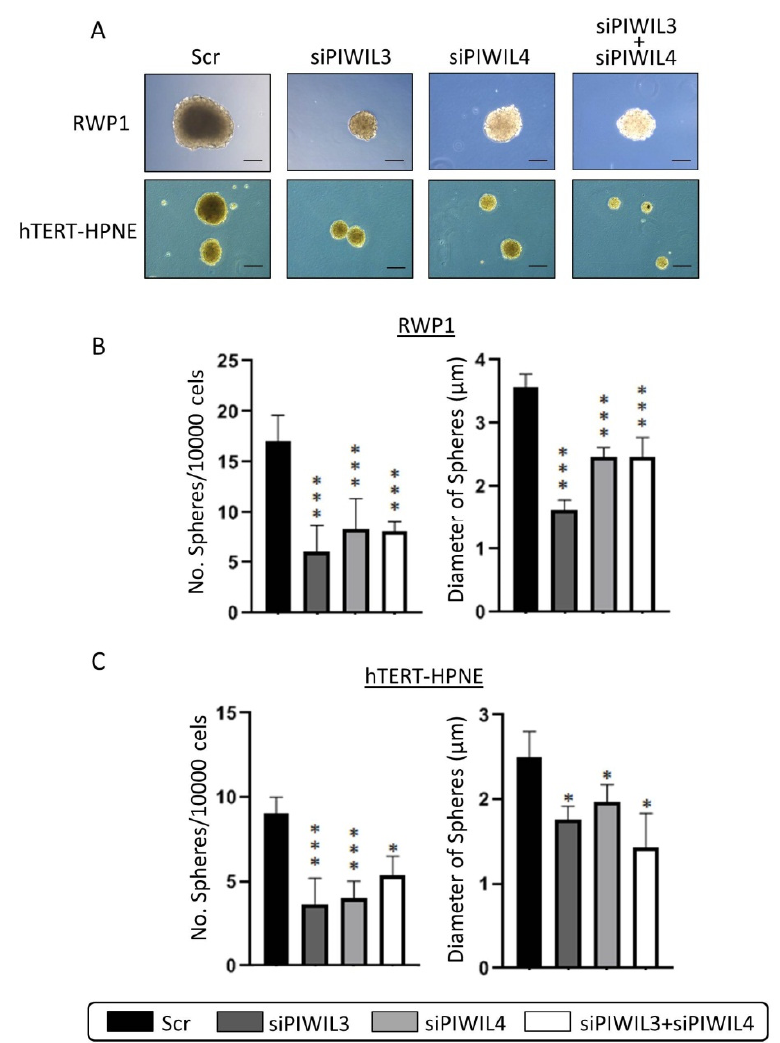
Figure 3. PIWIL3 and PIWIL4 impair undifferentiated phenotype. ( A ) Representative micrographs of undifferentiated pancreatic spheres derived from RWP1 and hTERT-HPNE transfected with siRNA for PIWIL3 (siPIWIL3) or PIWIL4 (siPIWIL4) downregulation individually or in combination. ( B ) Statistical analyses of number and diameter of spheres according to PIWIL3 and/or PIWIL4 downregulation of RWP1 cell line. ( C ) Statistical analyses of number and diameter of spheres according to PIWIL3 and/or PIWIL4 downregulation of the non-tumor hTERT-HPNE cell line. Color- coding for each protein downregulation is indicated in the legend box. Scr: scramble. Scale bar: 50 µm. * p < 0.05; *** p < 0.001.